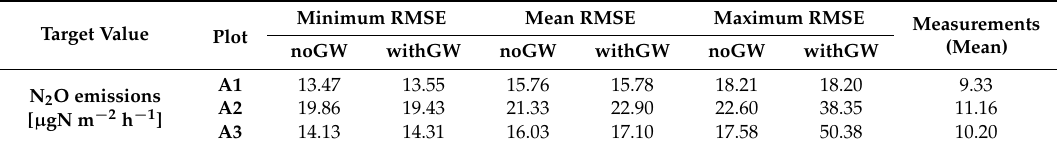
Figure 5. Measured data (black circles) and simulated confidence intervals for the monthly averaged N 2 O emissions (calculated as N 2 O-N) for the plots A1, A2 and A3 (from top). Confidence intervals for noGW simulations are shaded in light blue, withGW simulations are in light green and overlap between noGW and withGW in darker blue-green. Black lines depict the median for withGW (solid line) and noGW (dashed line) simulations. Additional information can be found in Tables A3 and A4. Table 4. RMSE for behavioural simulation runs of N 2 O emission.